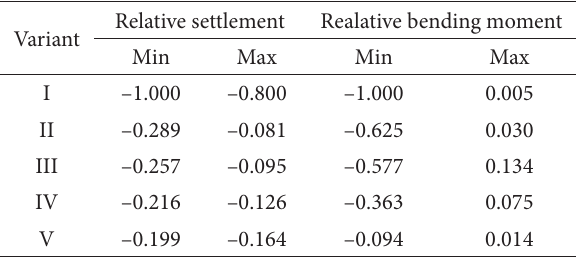
table 6. Extreme relative values of stress and strain parameters